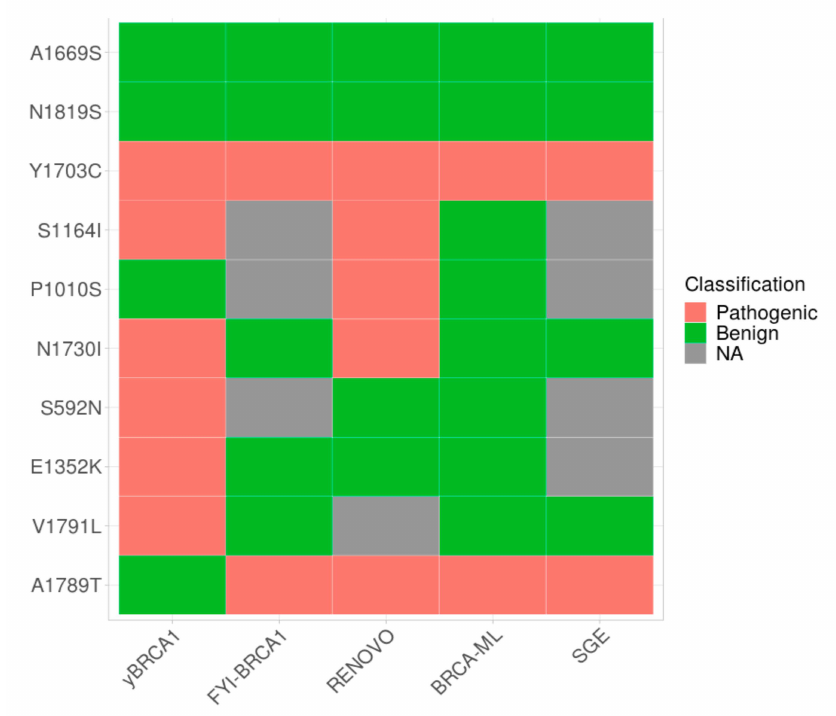
Figure 4. VUS classification by yBRCA1 and other methods. Heatmap showing the classification prediction of VUS that were selected in this study by yBRCA1, FYI-BRCA1, RENOVO, BRCA-ML, and SGE. NA: not